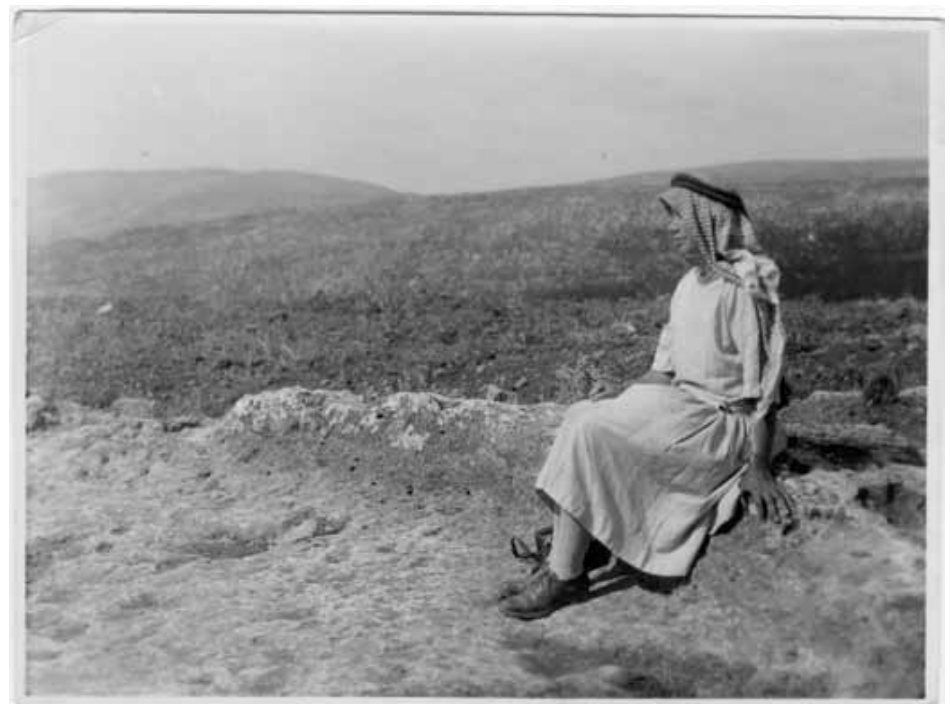
Fig. 2: Agnes Conway, c.1930s (IoA Horsfield Collection, P2008-796a; image courtesy of UCL Institute of Archaeology).